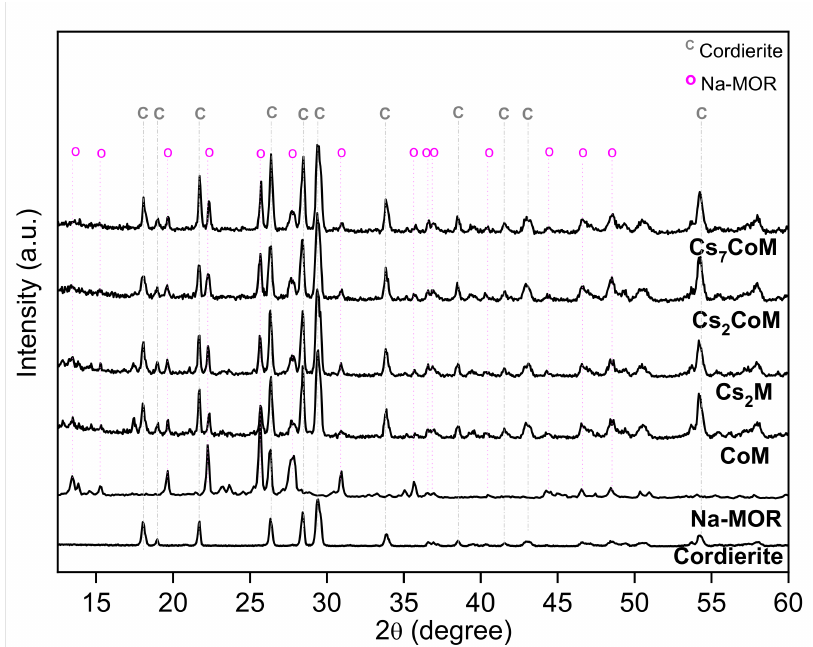
Figure 3. X-ray diffraction patterns of monolithic samples, cordierite, and